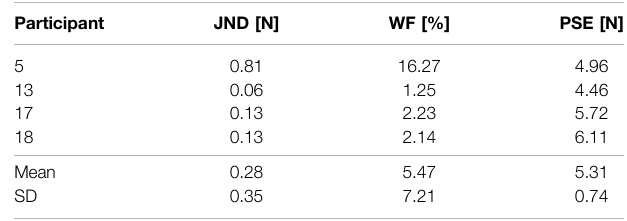
TABLE 1 | Results of four participants of our psychophysical user